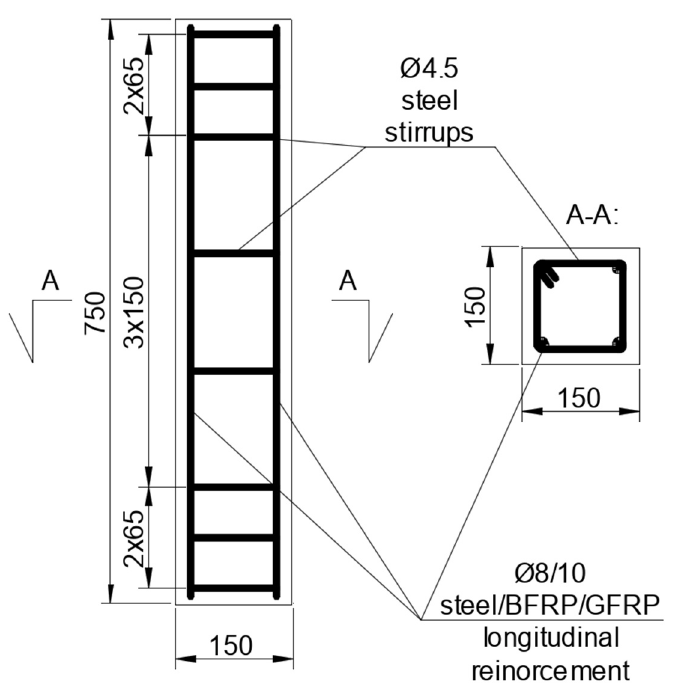
Figure 1. Reinforcement scheme, dimensions in mm.